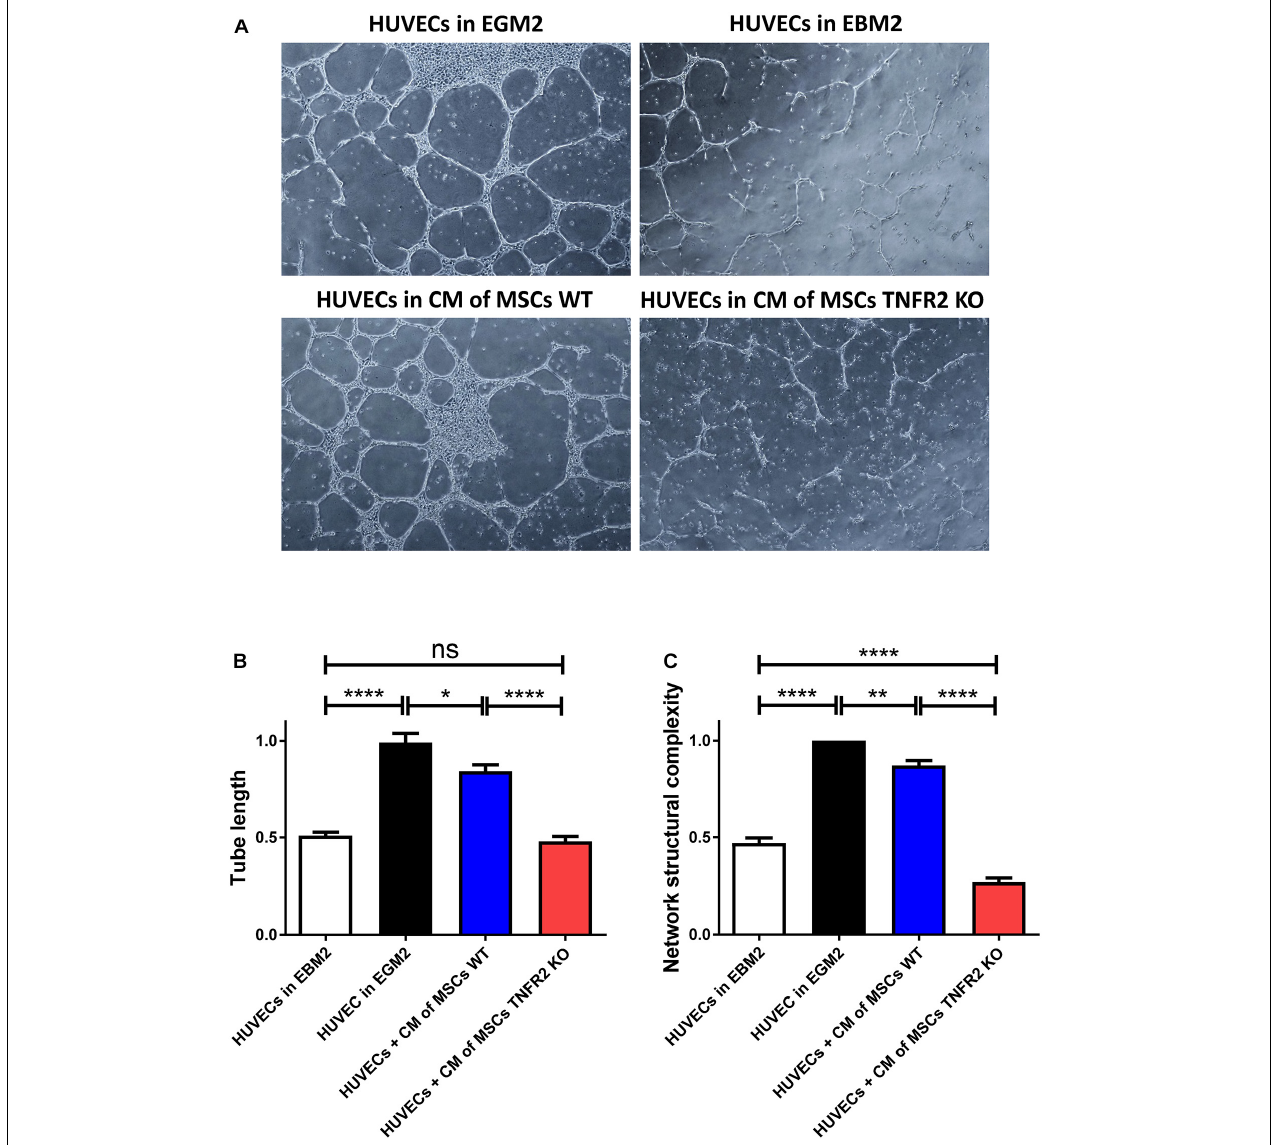
FIGURE 8 | Expression of TNFR2 is crucial for mesenchymal stem cells (MSCs) to support endothelial cell (EC) angiogenic function. To evaluate the impact of MSCs on human umbilical vein endothelial cell (HUVEC) angiogenic capacity, wild-type (WT) or TNFR2 knockout (KO)-MSCs (P2 and P3) were cultured in complete Dulbecco’s modified Eagle’s medium (DMEM) medium. After 2 days, CM were taken, filtered, and added to HUVECs on Matrigel. HUVECs cultured in EBM2 basal medium were used as negative control, and HUVECs cultured in EGM2 complete medium were used as positive control. (A) Pictures were taken every 2 h, using objectives 4 × and 10 × of the inverted microscope in phase-contrast mode. Images were further analyzed to evaluate (B) the tube length and (C) the network structural complexity. Results are collected from three independent experiments ( n = 10). CM, conditioned